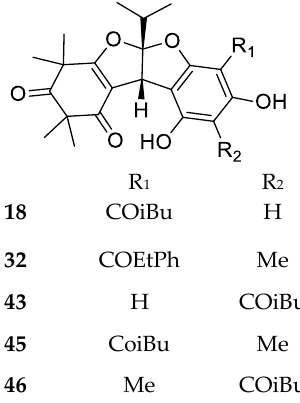
Figure 5. Structures of compounds of the trimeric-dipyrane type.